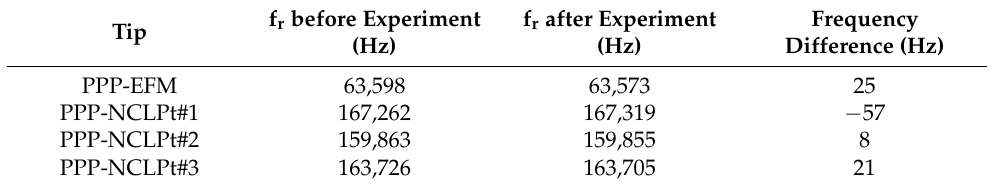
Table 2. Changes in the resonant frequency of the investigated probes before and after AFM imaging. f r before Experiment f r after Experiment Frequency Tip (Hz) (Hz) Difference (Hz) PPP-EFM 63,598 63,573 25 PPP-NCLPt#1 167,262 167,319 − 57 PPP-NCLPt#2 159,863